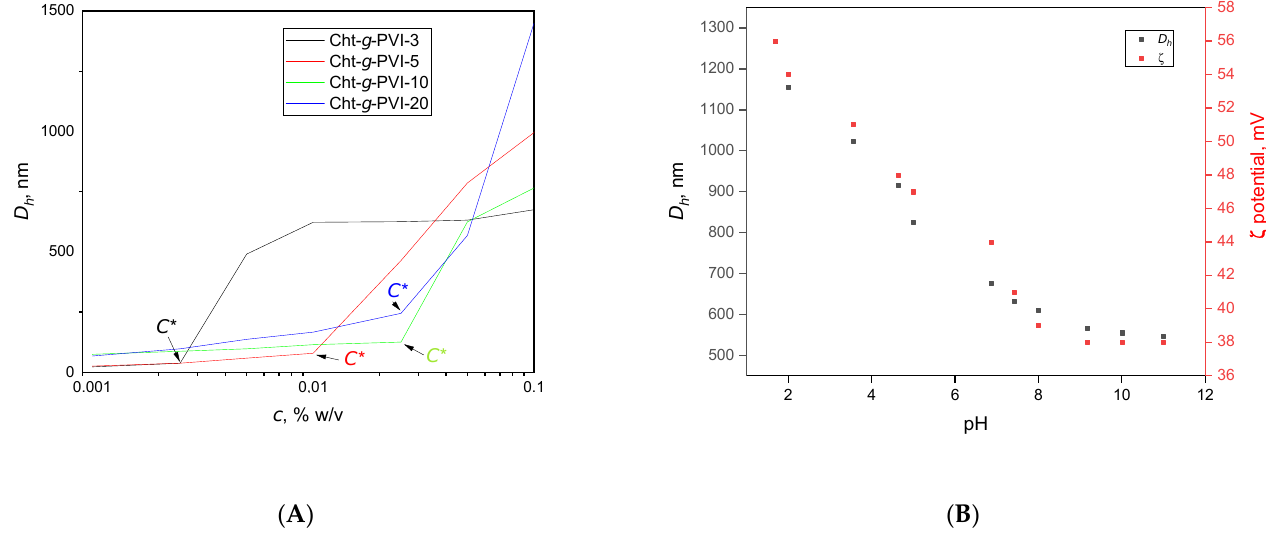
Figure 3. The dependency of the D h values on graft-copolymer concentration ( A ); the dependency of the D h and ζ -potential values on pH ( B )